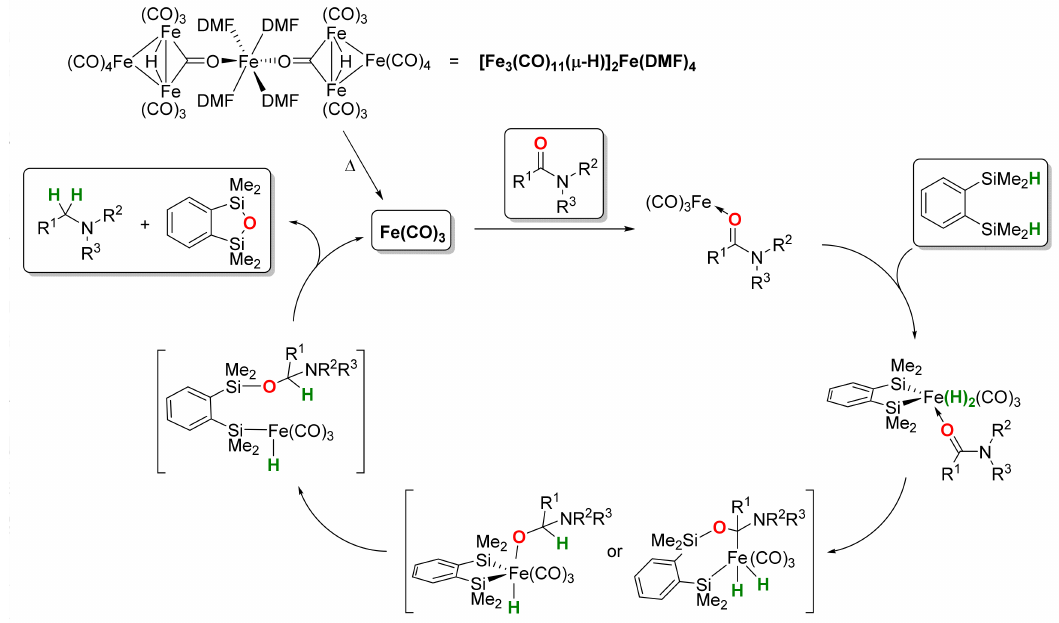
Scheme 7. hydrosilylation of